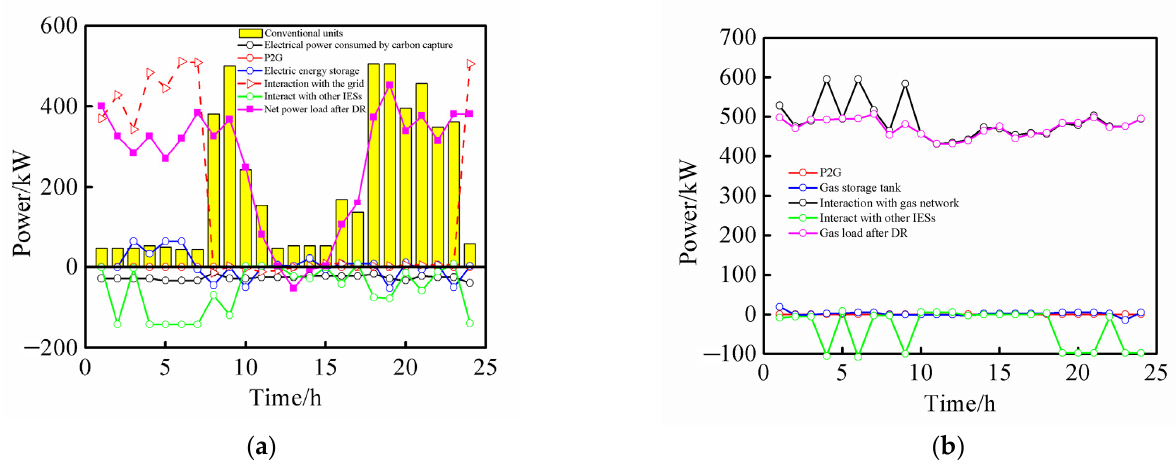
Figure 9. Balance diagram of Subsystem 3 under Scenario 4. ( a ) Electricity balance. ( b ) Gas balance.